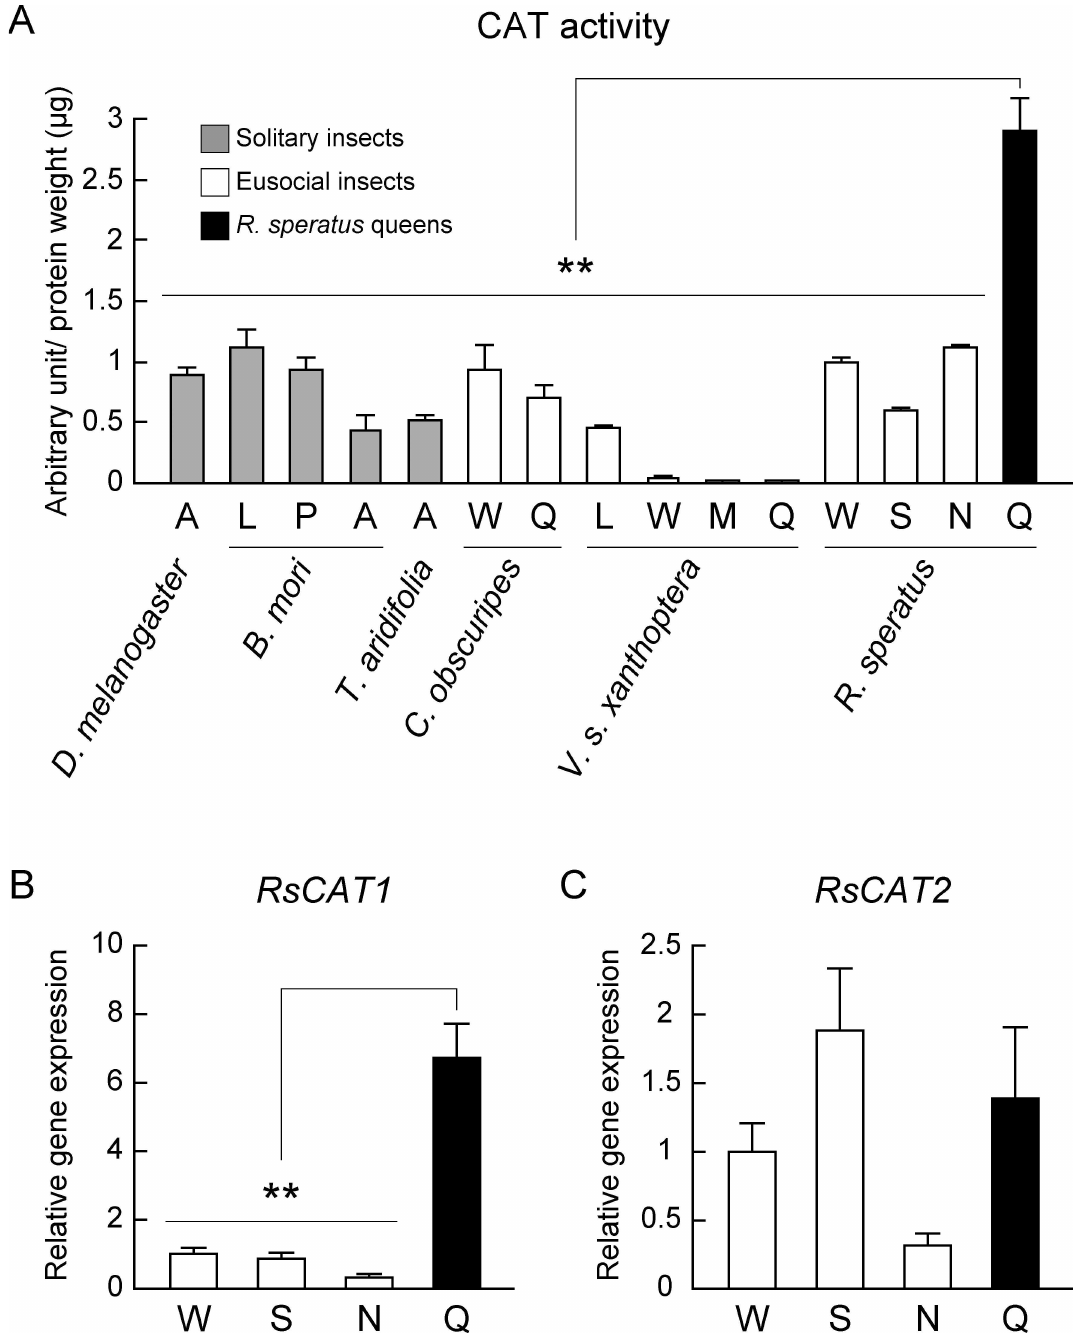
Fig 2. Termite queens have high CAT activity and gene RsCAT1 expression. A, adults; L, larvae; P, pupae;W, workers; M, male adults; Q, queens; S, soldiers; N, nymphs. (A) Queens of R . speratus ( n = 12) had markedly higherCAT activity than D . melanogaster adults ( n = 6; 10 individuals per replicate; P < 0.001), B . mori larvae ( n = 6; P = 0.001), B . mori pupae ( n = 6; P = 0.001), B . mori adults ( n = 6; P < 0.001), T . aridifolia adults ( n = 6; P < 0.001), C . obscuripes workers ( n = 6; 5 individualsper replicate; P = 0.001), C . obscuripes queens( n = 3; P = 0.001), V . s . xanthoptera larvae( n = 3; P = 0.001), V . s . xanthoptera workers ( n = 3; P = 0.001), V . s . xanthoptera adult males ( n = 3; P = 0.001), V . s . xanthoptera queens( n = 3; P = 0.001), R . speratus workers ( n = 6; P = 0.001), R . speratus soldiers( n = 6; P < 0.001), and R . speratus nymphs ( n = 6; P = 0.001). The values of CAT activity in solitary insects were pooledmale-female data (1:1). (B) Queens of R . speratus ( n = 9) also showed higher CAT gene RsCAT1 expressionthan non-reproductive workers ( n = 12; P < 0.001), soldiers ( n = 12; P < 0.001), and nymphs ( n = 12; P < 0.001). (C) There was no difference in CAT gene RsCAT2 expressionbetween